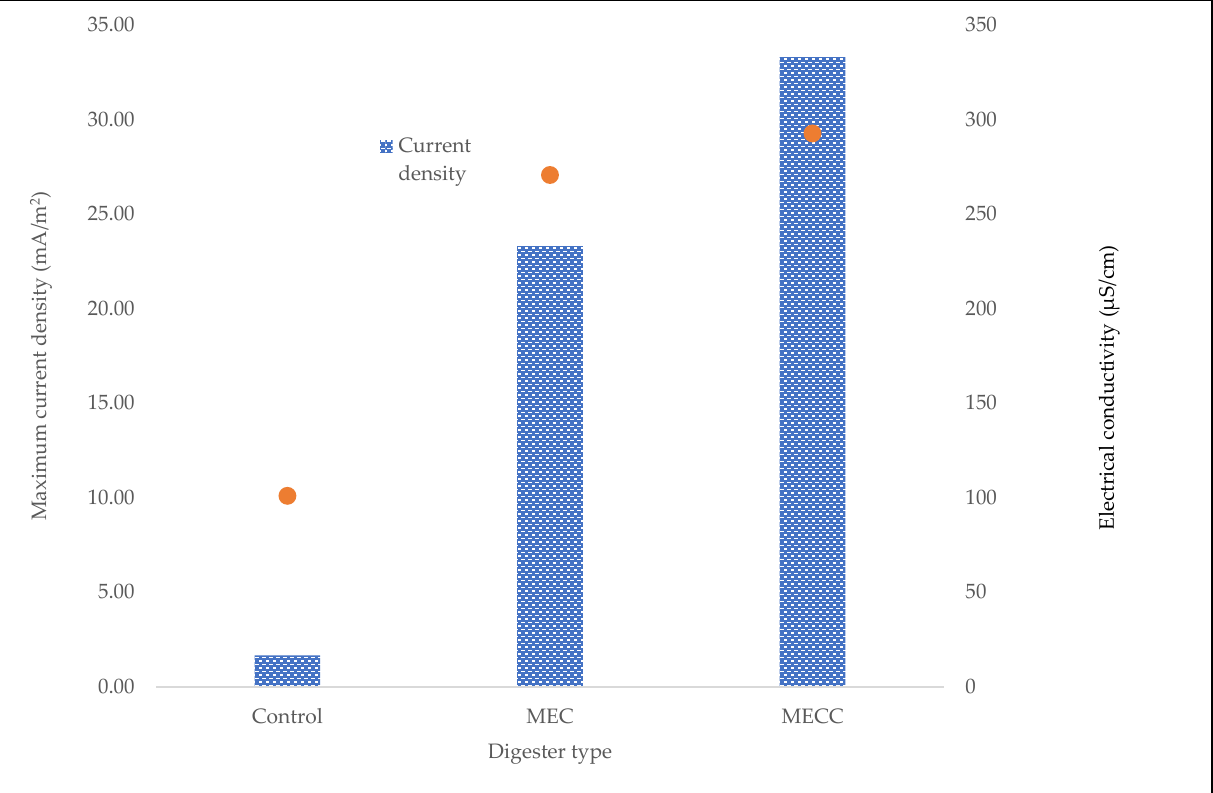
Figure 6. Influence of maximum current density on electrical conductivity. The degree of impact exerted by a magnetic field or electromagnetism on the kinetics of the electrode mechanism is currently regarded as highly debatable. Based on Tafel data [40], electromagnetism has no substantial influence on the kinetics of the electrode mechanism; electromagnetism is achieved in magneto-impedance experimentations. Conversely, other studies have confirmed that exposure to high magnetic field strengths result in blockage of current density [24]. In this study, the current had a significant effect on electromagnetism; there was a direct relationship between current and magnetic field strength ( Error! Reference source not found. ). Biot-Savart’s law also confirms that current s directly proportional to magnetic field, as shown in Equation (2):